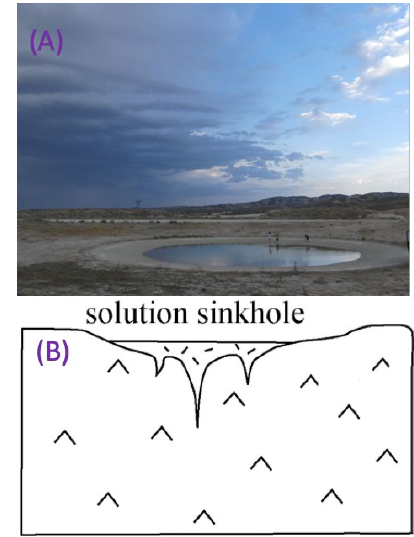
Figure 1. View of solution sinkhole on the surface of gypsum rock: (A) Panoramic view; (B) Interpretive scheme of solution sinkhole in